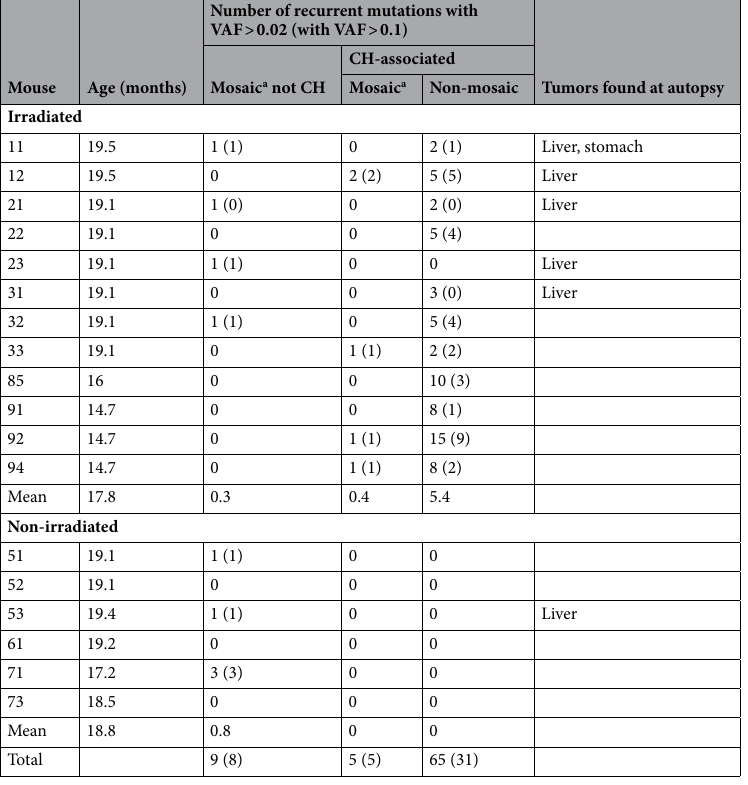
Table 1. Number of recurrent somatic mutations detected in 3 Gy-irradiated and non-irradiated mice. a Mosaic mutations present in non-hematopoietic tissues. Each mouse (numbers 23 and 94) had one mosaic deletion; all other mutations were single-nucleotide variations. VAF, variant allele frequency.